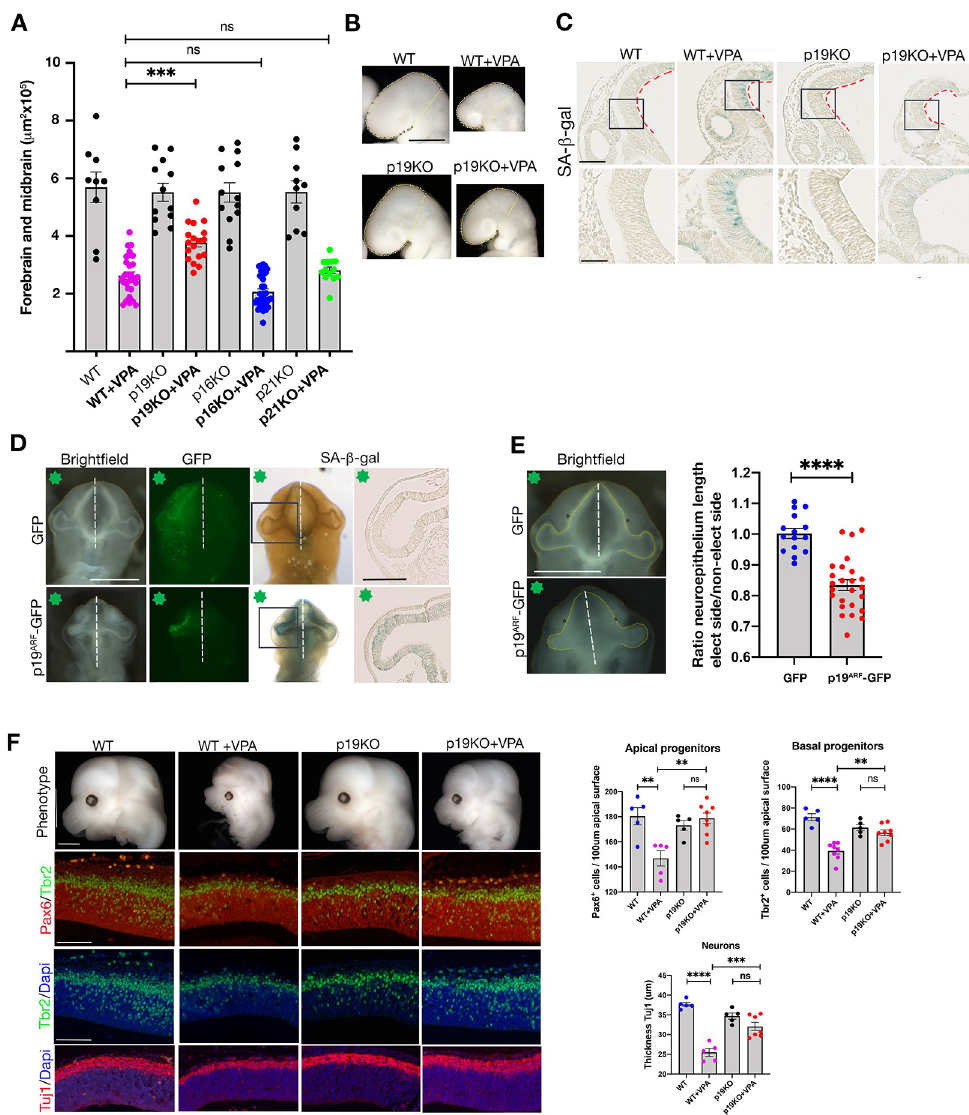
Fig 5. p19 Arf expression causes senescence and VPA-induced microcephaly. (A) Graph shows surface area of forebrain and midbrain in each condition, WT, n = 9 embryos from 4 litters, WT+VPA, n = 29 embryos from 14 litters, p19KO, n = 12 embryos from 4 litters, p19KO + VPA, n = 18 embryos from 7 litters, p16KO, n = 13 embryos from 4 litters, p16KO + VPA, n = 34 embryos from 8 litters, p21KO, n = 11 embryos from 4 litters, p21KO + VPA, n = 13 embryos from 8 litters. Data bars represent mean ± SEM. Kruskal–Wallis test: ns, not significant, �� p � 0.01 and ���� p � 0.0001. (B) Bright field images of E9.5 embryonic heads, indicating area of the forebrain and midbrain (yellow line). Scale bar, 500 μ m. (C) Representative brain sections of E9.5 SA- β -gal stained WT or p19KO (scale bar, 100 μ m). Box shows the region imaged in lower panel (scale bar, 50 μ m). Red dashed lines indicate apical surface of the neural tube. WT, n = 5 embryos from 3 litters, WT+VPA, n = 6 embryos from 4 litters, p19KO n = 5 embryos from 3 litters for p19KO, p19KO + VPA n = 9 embryos from 3litters. (D) Ventral views of chick embryos at stage HH12, electroporated with a GFP or a p19 Arf -GFP plasmid. Green star indicates electroporated side. Scale bar, 500 μ m. Embryos were stained for SA- β -gal activity. Boxes indicate sectioned area of forebrain neuroepithelium shown. Scale bar, 100 μ m (E) Brightfield embryos with yellow line shows length of neuroepithelium. Scale bar, 500 μ m. Graph shows ratio of length of neuroepithelium in electroporated side compared to control side. GFP, n = 15 embryos from 4 different electroporations, p19 Arf -GFP, n = 25 embryos from 9 different electroporations. Data bars represent mean ± SEM. Unpaired t test: ���� p � 0.0001. (F) Images showing the cortical vesicles from microcephaly embryos. Scale bar, 1 mM. Immunostaining on cortical sections, E.13.5, for Pax6, Tbr2, Tuj1, and counterstained with Dapi. Scale bar, 100 μ m. Graphs showing number of Pax6 and Tbr2 positive progenitors or the thickness of the Tuj1 neuronal layer in the cortical vesicles (for each condition, minimum 5 embryos from at least 4 different mothers were analyzed). Data bars represent mean ± SEM. One-way ANOVA plus